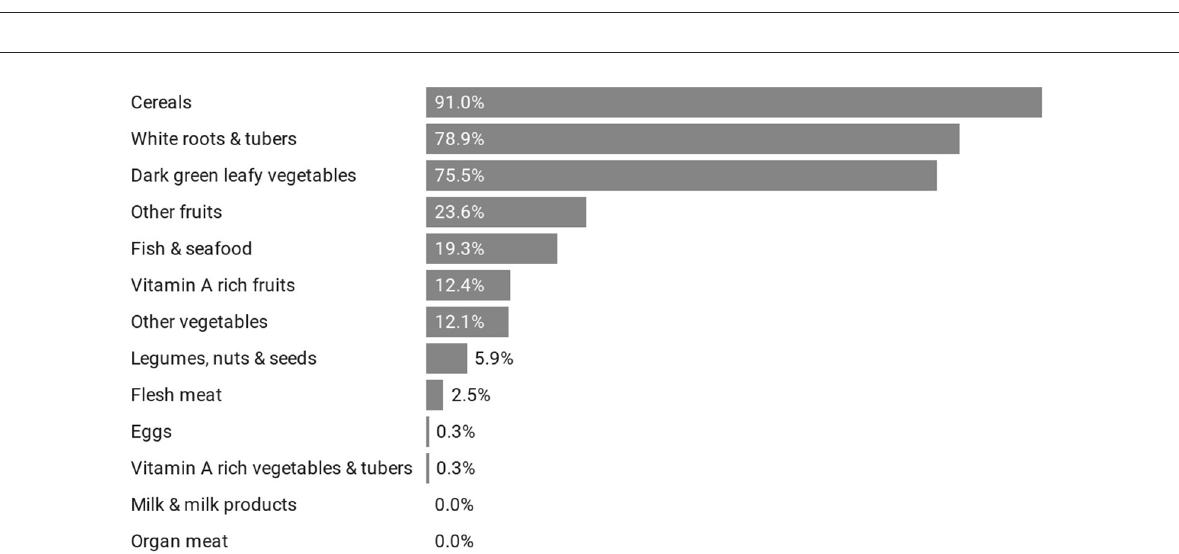
FIGURE4 Percentage of respondents employing types of food insecurity coping strategies ( n = 320).